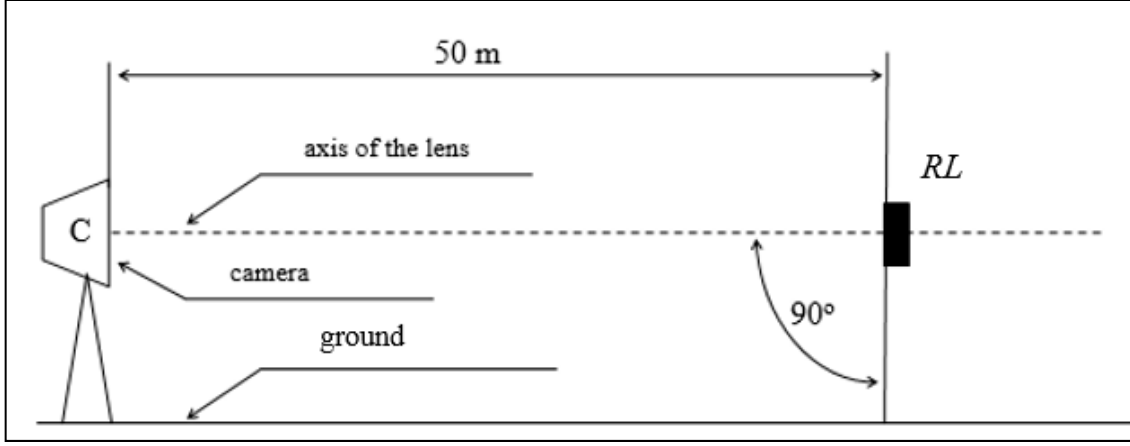
Figure 5. Basic scheme for reference length scanning—side view (source: The authors of this article).